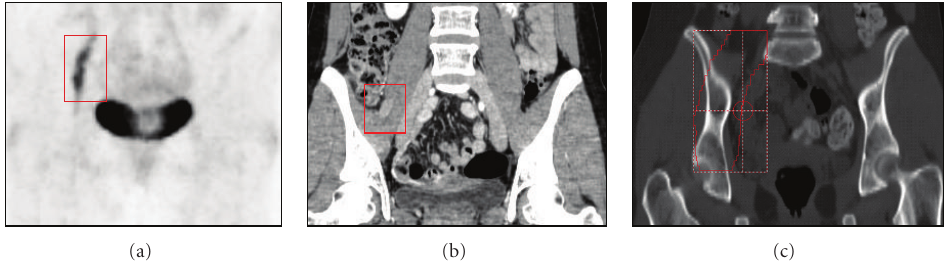
Figure 2: Recurrent neurotropic chloroma of the right femoral nerve outlined in red on (a) pretreatment Positron Emission Tomography (PET) and (b) coronal Computerized Tomography (CT) imaging with the (c) CT-based treatment field outlined in